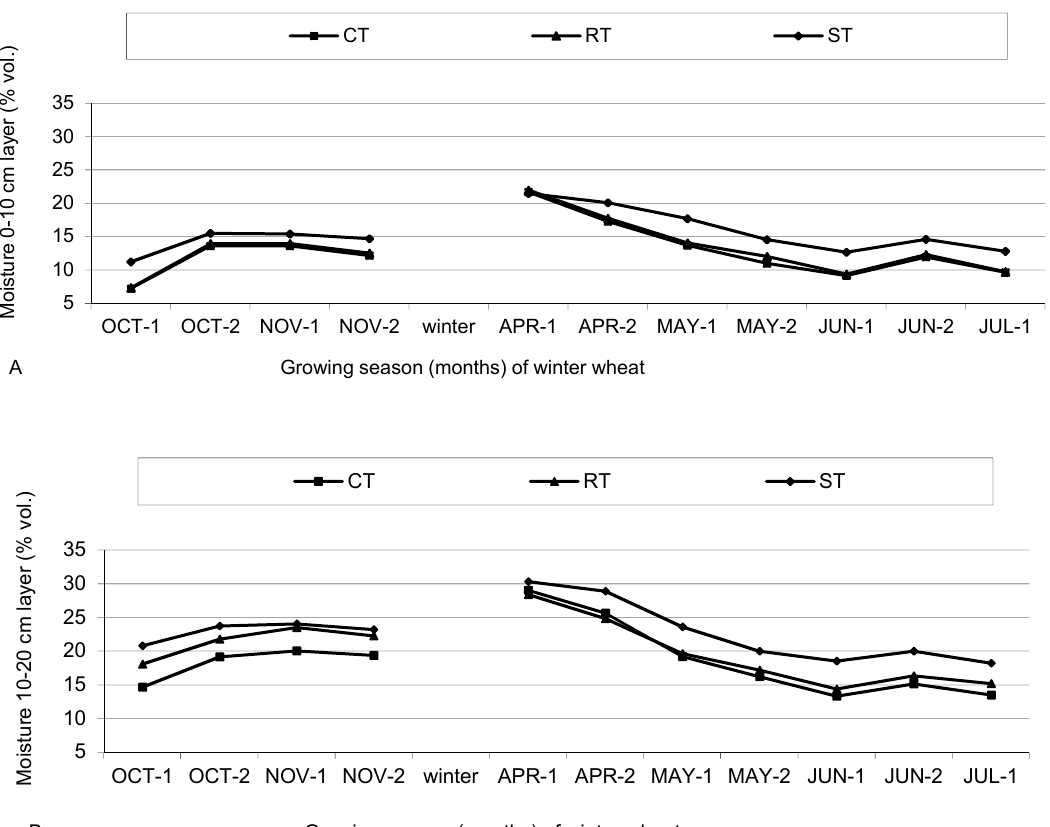
Figure 4. Soil moisture in the 0–10 cm ( A ) and 10–20 cm ( B ) layers during the growing season of winter wheat depending on the basic tillage, pre-sowing fertilisation, and sowing technology (average in the three research years).